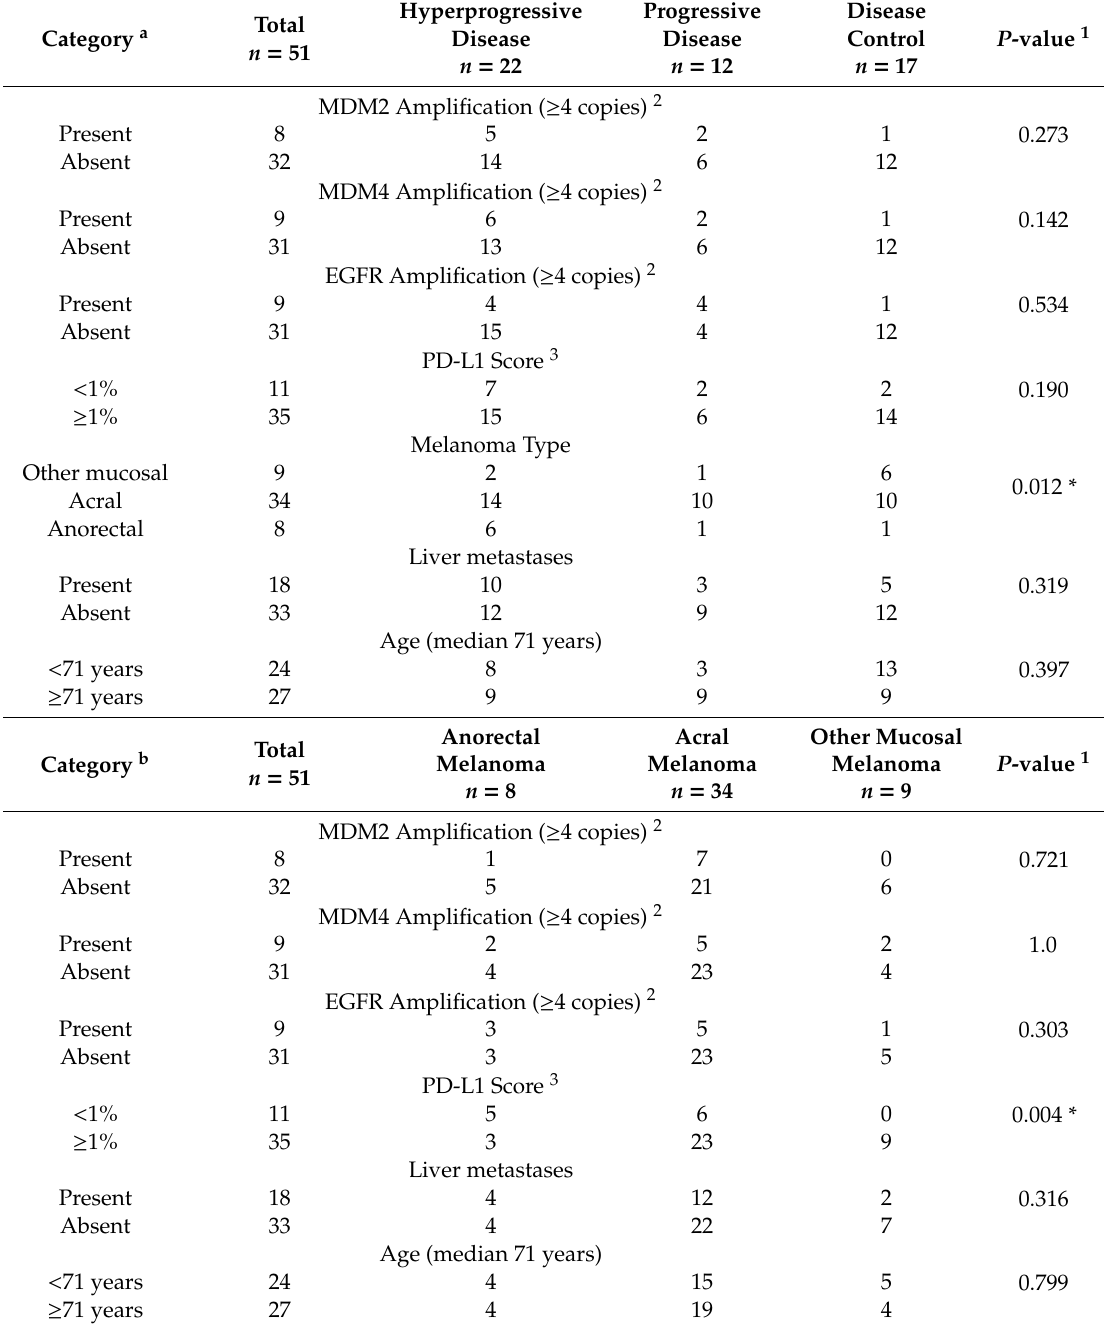
Table 2. Characteristics and ICI treatment response. a Genetic pattern and clinical characteristics according to treatment response. b Genetic pattern and clinical characteristics according to melanoma